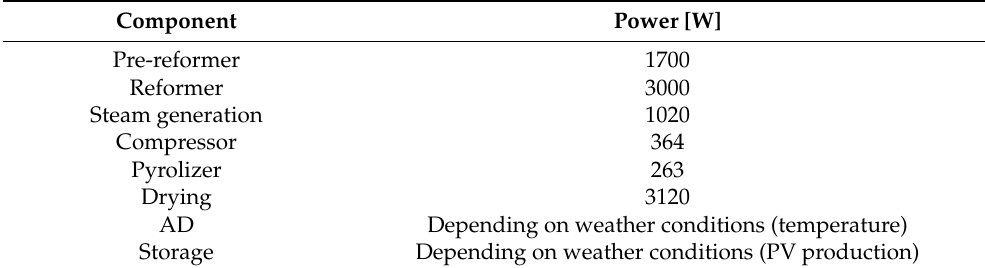
Table 3. Power demand of the system components. The drying power is derived from [34], while the power of the other components is directly evaluated from the simulation. Component Power [W] Pre-reformer 1700 Reformer 3000 Steam generation 1020 Compressor 364 Pyrolizer 263 Drying 3120 AD Depending on weather conditions (temperature) Storage Depending on weather conditions (PV